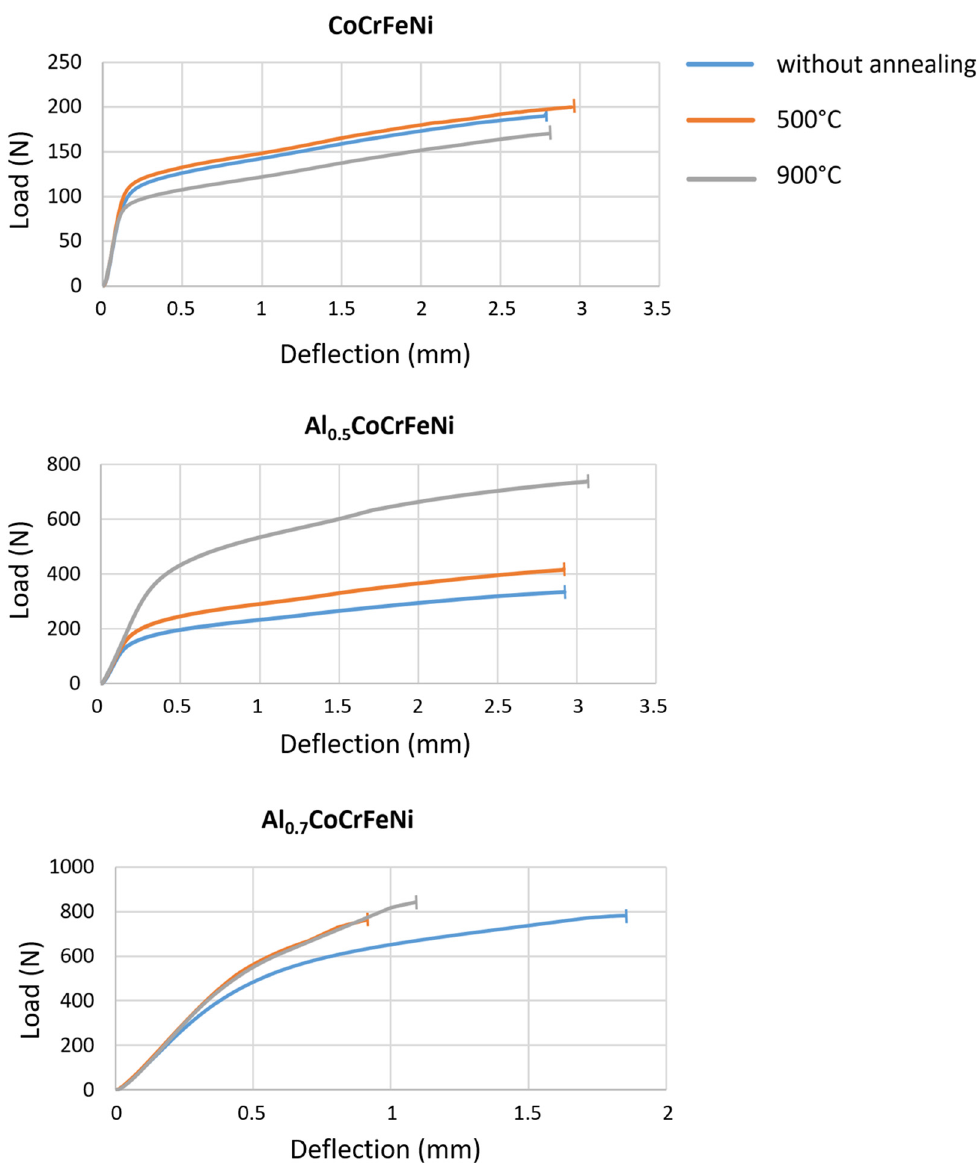
Figure 9. Averaged load–displacement curves. Selected alloy properties determined from the three-point bending test are shown in Figures 10 and 11.